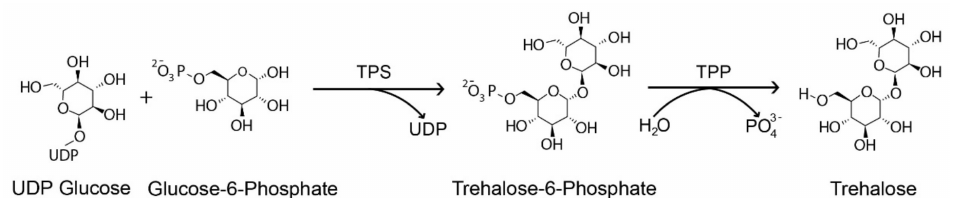
Figure 1. Trehalose biosynthesis pathway in plants. Uridine diphosphate glucose (UDP), Trehalose-6- phosphate synthase (TPS) and Trehalose-6-phosphate phosphatase